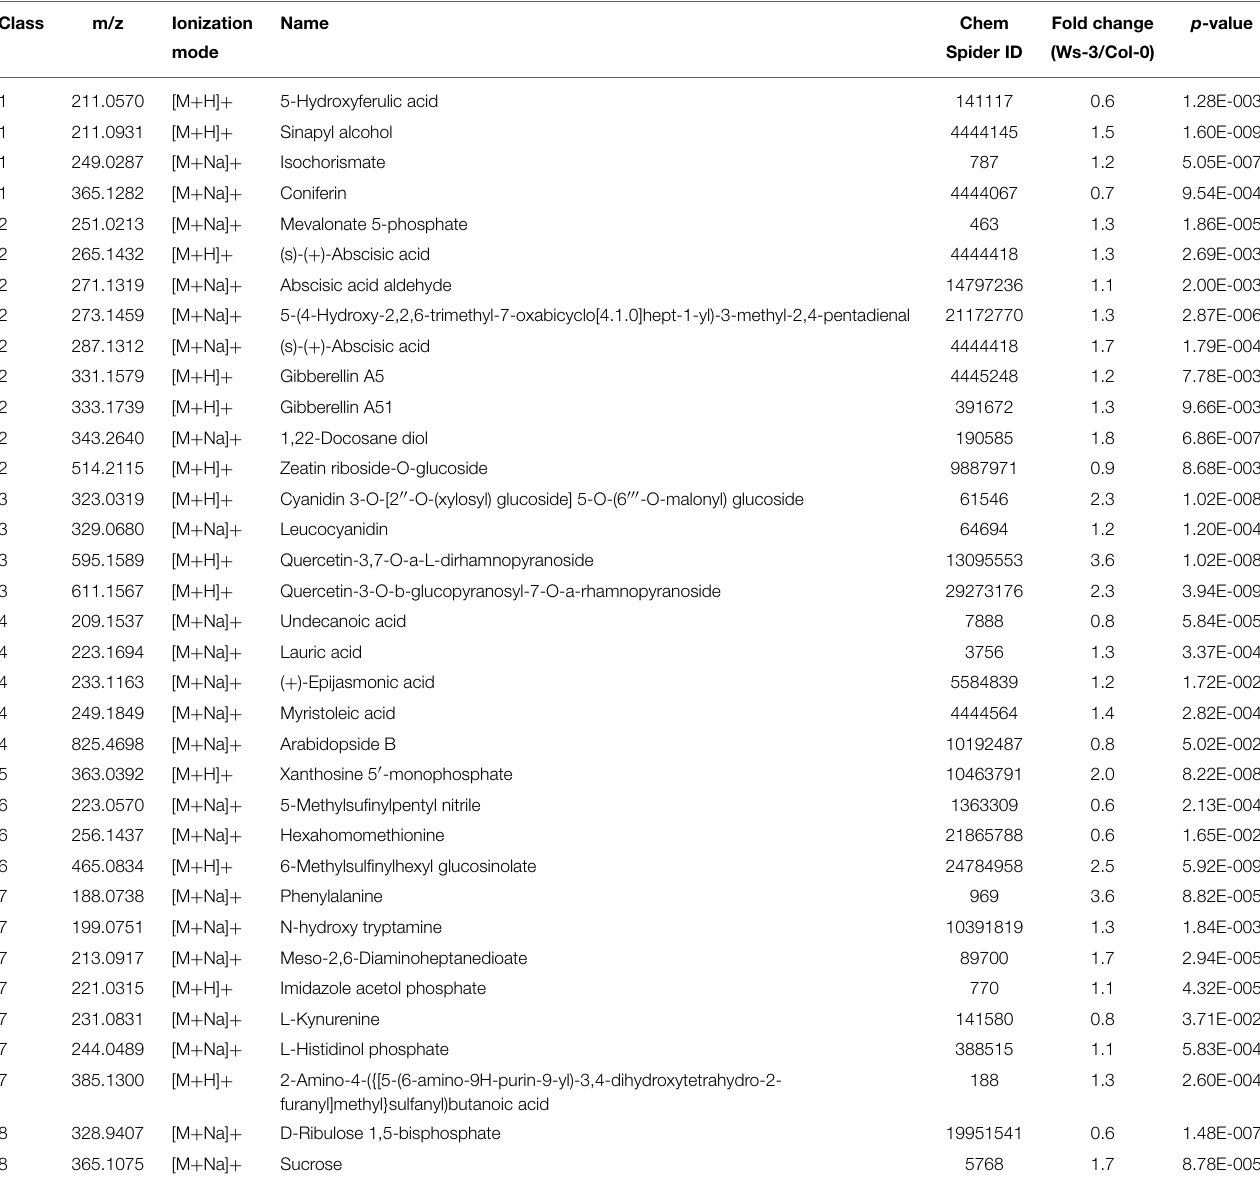
TABLE 2 | Relative amounts of metabolites putatively identified by ACQUITY UPLC-LCT Premier XE (Waters) in crude extracts from inflorescences of Ws-3 and Col-0 Arabidopsis thaliana